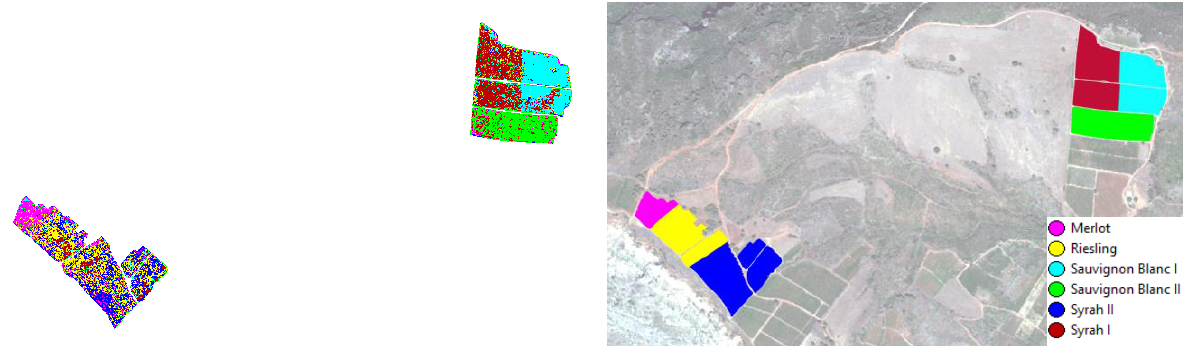
Figure 2. Vine variety discrimination results in the Trapeza study area. Six different vine varieties were discriminated i.e., Merlot, Riesling, Sauvignon Blanc clone I, Sauvignon Blanc clone II, Syrah clone I and clone II. The quantitative evaluation resulted at overall accuracy rates of 61% at pixel level and 100% at parcel level.